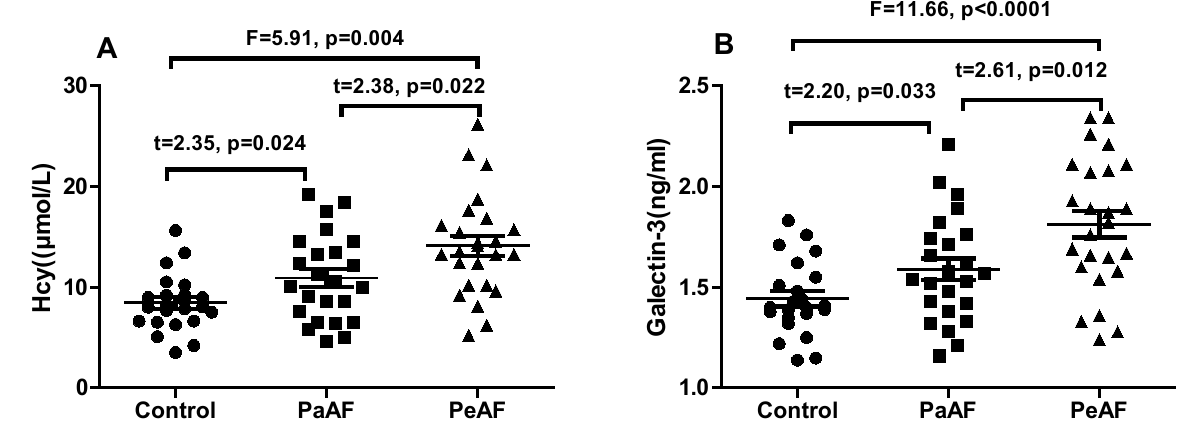
Figure 2: Scater plot of serum Hcy, Galectin-3 concentration for different groups(A: Serum Hcy for control, PaAF, PeAF groups; B: Serum Galectin-3 for control, PaAF, PeAF groups).